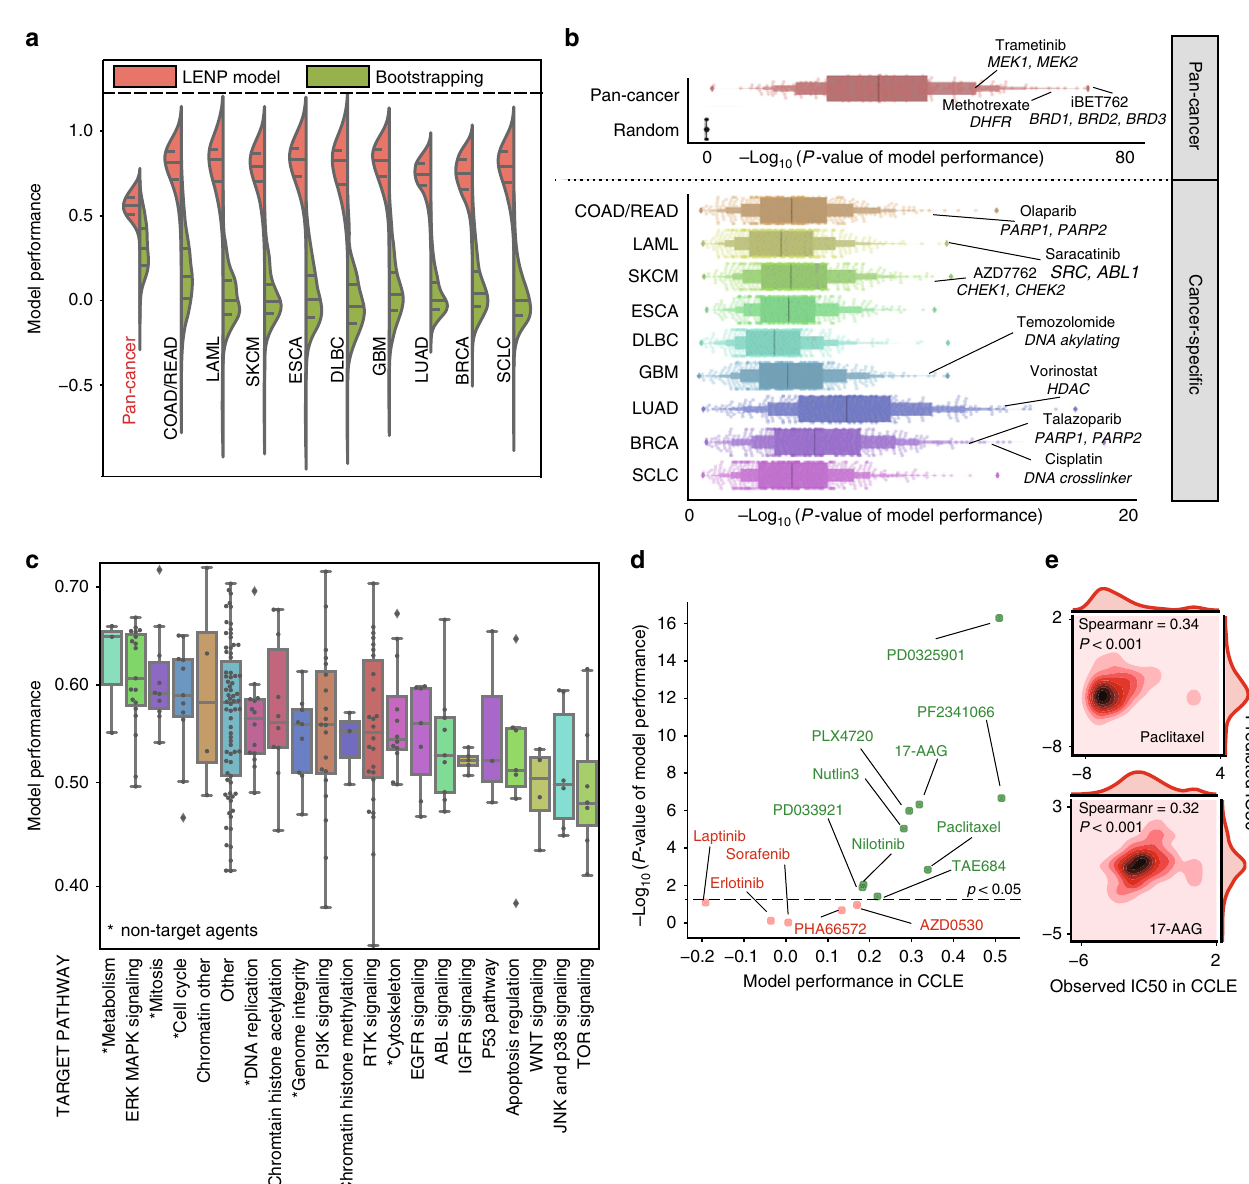
Fig. 3 LncRNA-based EN-prediction models predict drug response in cancer cell lines. a Performance comparison between LENP and bootstrapping EN models for 265 drugs in pan-cancer and speci fi c cancer types. Model performance is shown on the y -axis. b LENP performance of pan-cancer models and cancer-speci fi c models using top 20 predictive lncRNAs for each agent. c Pan-cancer LENP performance for agents from different target pathways. center lines represent median performance, the box limit indicates the lower quantile and upper quantile, and whiskers represent the poorest and best performance. d Prediction performance of LENP models in CCLE data. The performance is assessed by Spearman correlation coef fi cients ( x -axis) and − log10-transformed p -value of real IC50s in CCLE versus predicted IC50s by lncRNA-based EN models. Label colors demonstrated the signi fi cance: the model with p -value <0.05 is considered as having good independent validation performance. e Performance of LENP in selected agents from CCLE datasets. Observed and predicted IC50 for CCLE dataset were represented in the x -axis and y -axis,